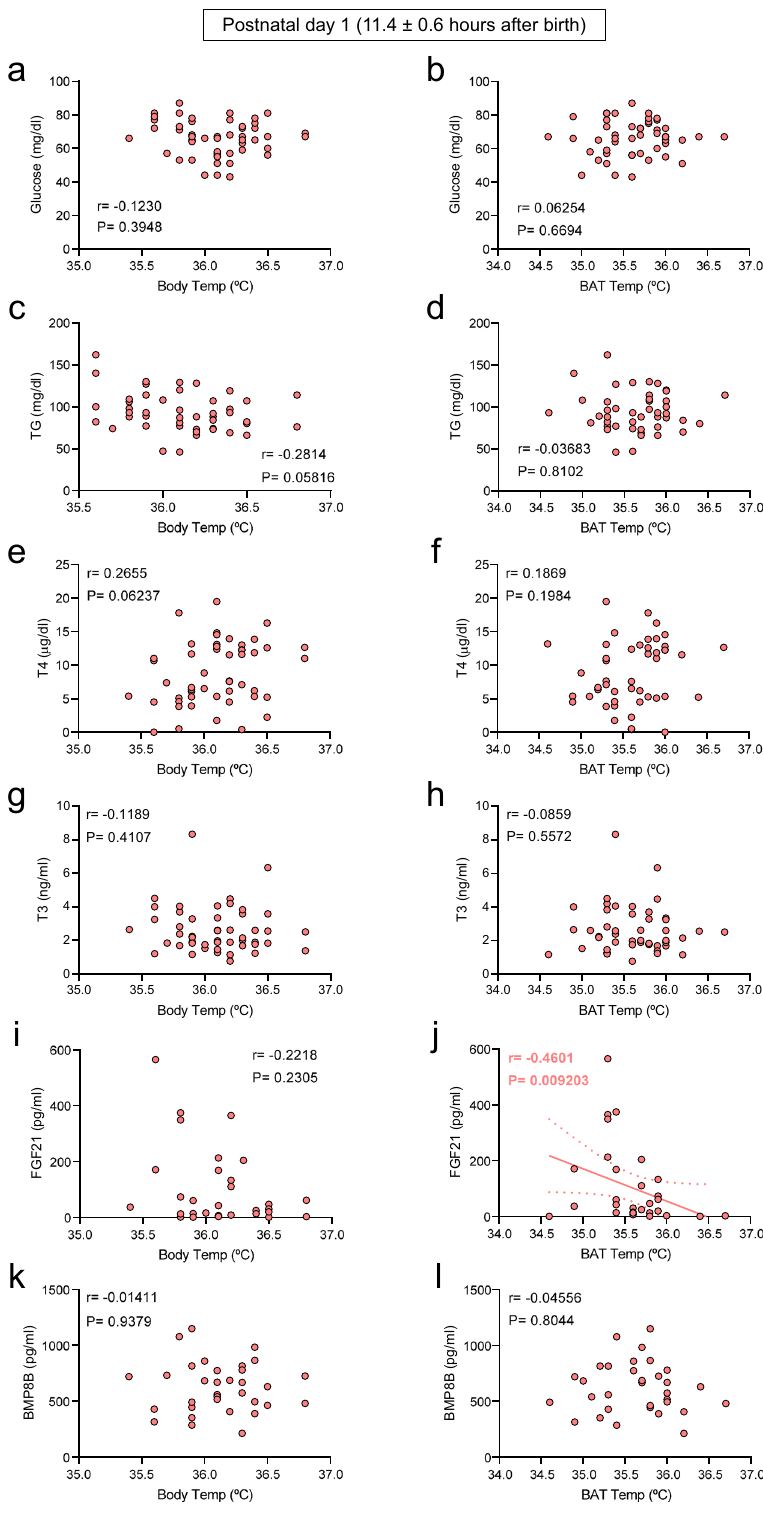
Fig. 4 Correlations between body and BAT temperatures and circulating parameters in control 1-day old newborns. Correlation between body temperature ( a , c , e , g , i , k ) and BAT temperature ( b , d , f , h , j , l ) in newborns in control conditions at postnatal day 1. Number of newborns: a 50, b 49, c 46, d 45, e 50, f 49, g 50, h 49, i 31, j 31, k 33, and l 32. Association analysis was performed by two-sided Pearson ’ s test or Spearman ’ s test; regression line with 95% con fi dence interval was added when correlation was signi fi cant. Source data are provided as a Source data fi